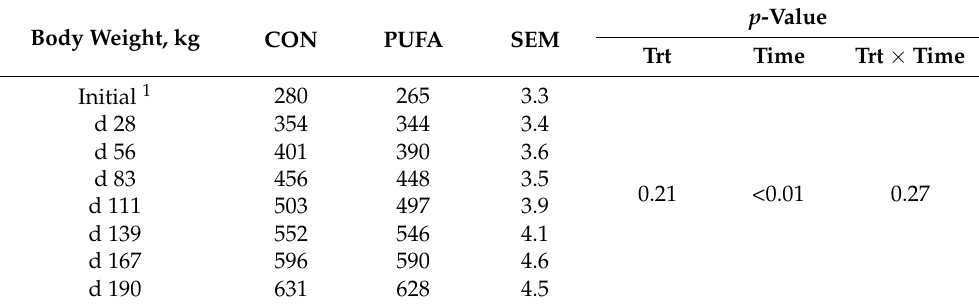
Table 3. Effects of supplementing cows with either 155 g DM/d EnerGII (CON) or 80 g DM/d Strata + 80 g DM/d Prequel (PUFA) for the last 77 ± 6 d of gestation on steer progeny finishing phase body weight.